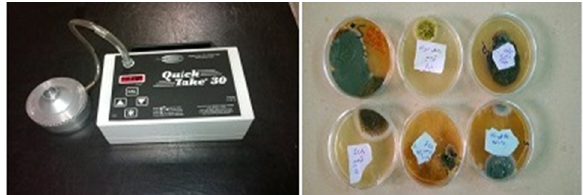
Fig. 1. Airborne fungal spores plates and related air sampling